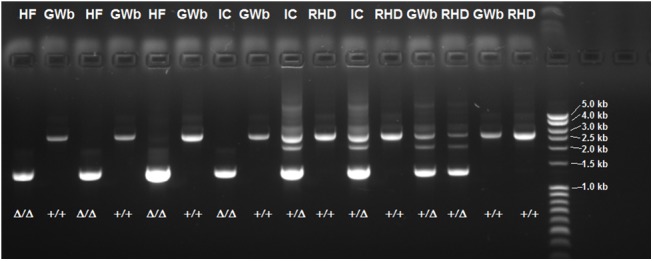
Agarose gel electrophoresis of PCR products spanning the 1.3 kb deletion.The upper visible band corresponds to the long variant (denoted as +), the lower one to the short variant containing the deletion (denoted as Δ). Only in heterozygotes, a third band with a size of approximately 2.1 kb is visible, which is possibly arising from asymmetric hybridization of the alleles due to the presence of a duplication. The breeds of the corresponding samples are given above the lanes (RHD = Russian Heavy Draft, GWb = German Warmblood, IC = Icelandic horse, HF = Haflinger).